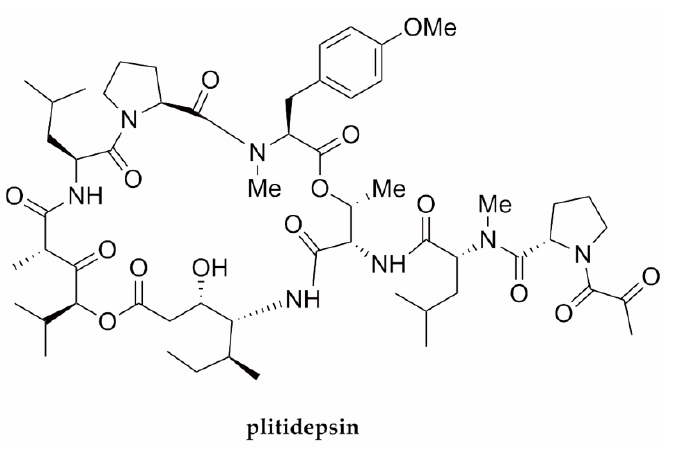
Figure 6. The chemical structure of plitidepsin — a marine ‐ derived peptide exhibiting an ‐ ti ‐ SARS ‐ CoV ‐ 2 activity. 2